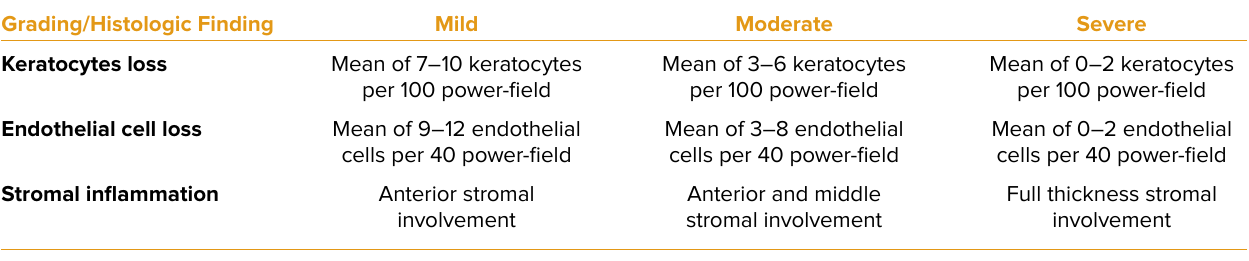
Table 1. Histological grading for the loss of keratocytes, endothelial cells, and stromal inflammation